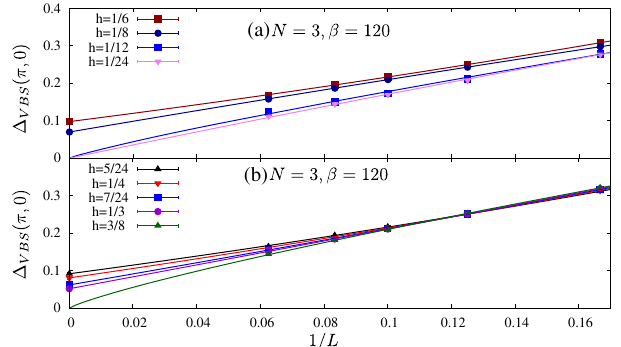
FIG. 17. SU(3) VBS order parameter. At h ¼ 1 = 12 , corre- sponding to a rough estimate of the transition from the Z 2 Dirac deconfined to the dimerized phase, we fit the data to the form aL − b . The transition from the VBS phase to the AFM one occurs approximately at h ¼ 2 = 3 . For this value of h , the data are consistent with a large η ¼ 2 b − 1 exponent, η ≃ 0 . 6 , which is larger than the one obtained for the J-Q model at SU(3) η ≃ 0 . 5 (see Ref. [54]).